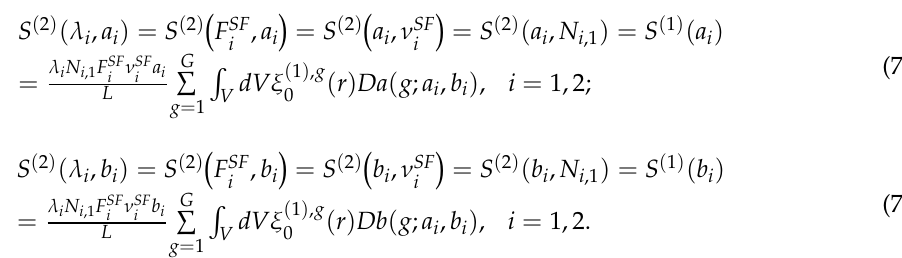
(cid:16) (cid:17) q j , q m , j , m 2 = 1, ... , J q of the leakage response with 2